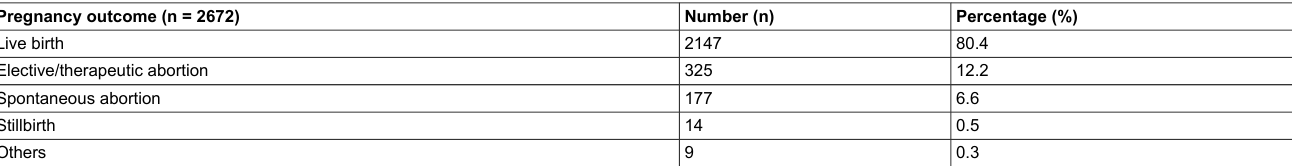
Table S1: Pregnancy outcomes documented in the follow-up of queries during singleton pregnancies with exposures to